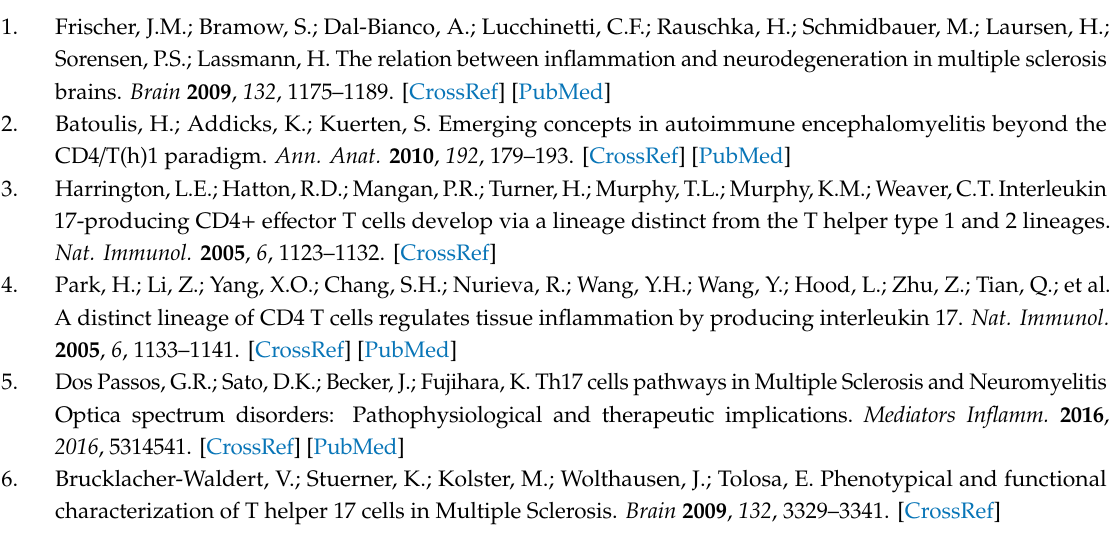
Figure S1: Comparison of CD28-mediated up-regulation of glycolysis between CD4 + T cells from HD and RRMS, Figure S2: CD28 stimulation up-regulates the expression of surface activation markers and inflammatory cytokines in CD4 + T cells from RRMS patients, Figure S3: CD28-stimulation up-regulates Glut1 expression in CD4 + T cells from RRMS